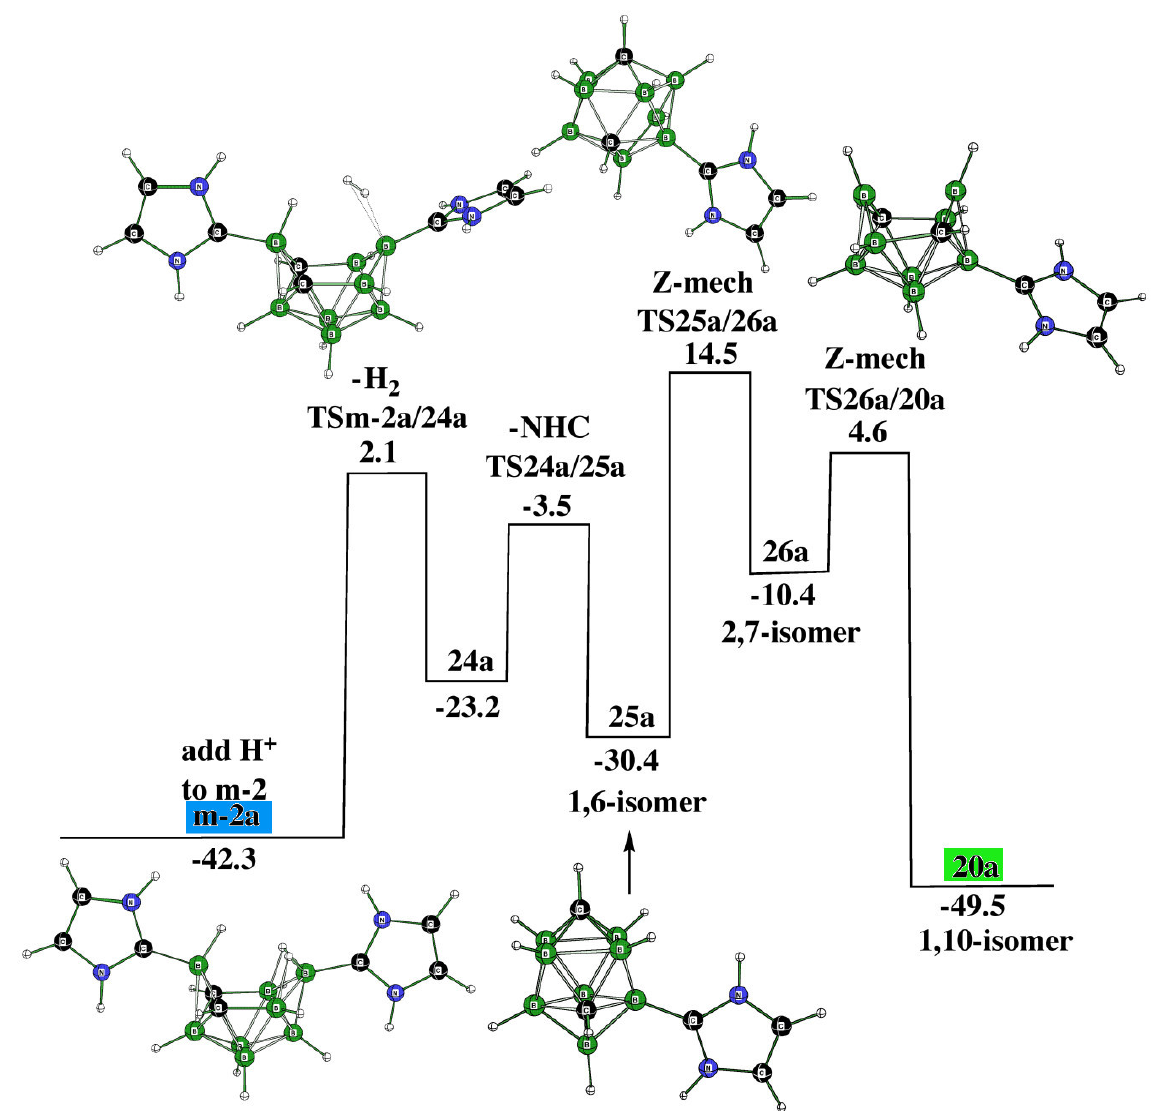
Figure 10. Relative free energies (kcal.mol − 1 ) of the individual stationary points on the potential energy surface (PES) of the transformation of m ‐ 2a through the cationic 25a based on the 1,6 ‐ isomer and two Z ‐ rearrangements to the fi nal 20a (see Tables 1 and S1 and Section 3 for details).